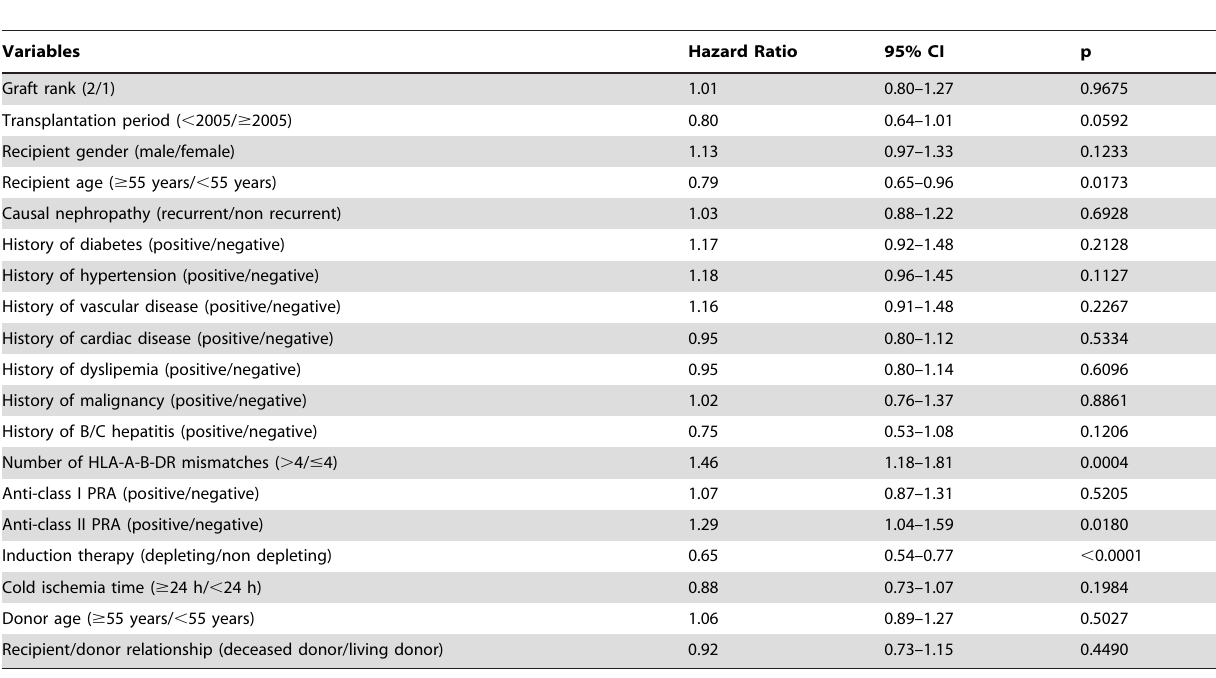
Table 3. Multivariate Cox model analysis of acute rejection episode (ARE)-free time risk factors (N =3103).